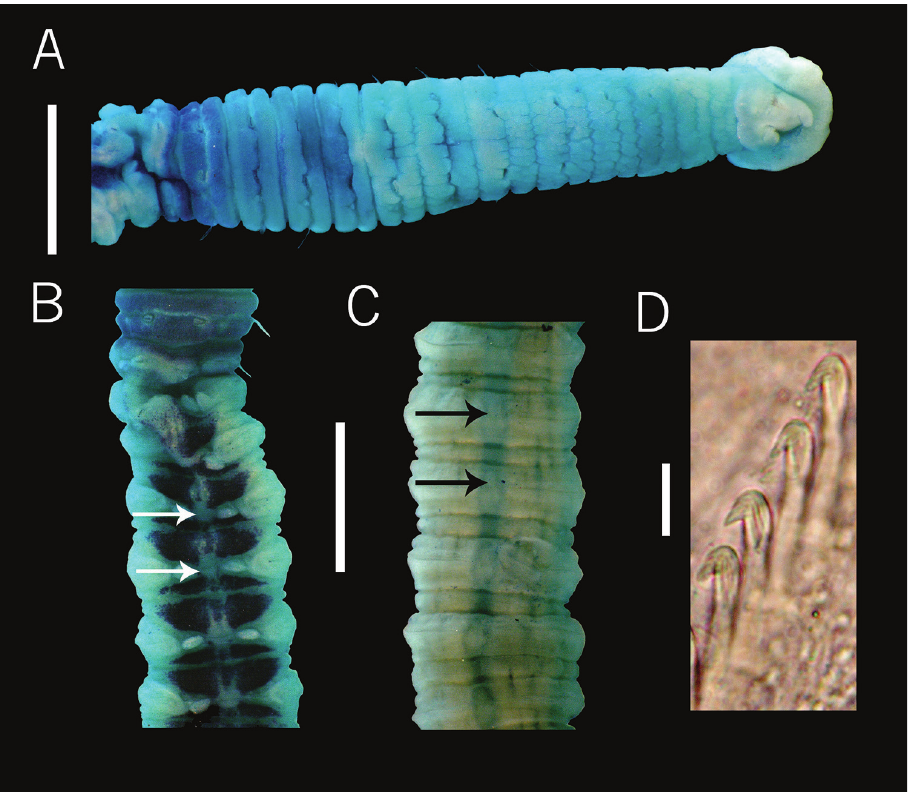
Figure 2. Paratype of Dodecaseta fauchaldi (Green, 2002). A anterior end, dorsal view B chaetigers 12- 19, dorsal view C chaetigers 21-26, ventral view D neurohook of chaetiger 40, lateral view. Methyl green stain A . Scale bars: A–C = 1mm, D = 15